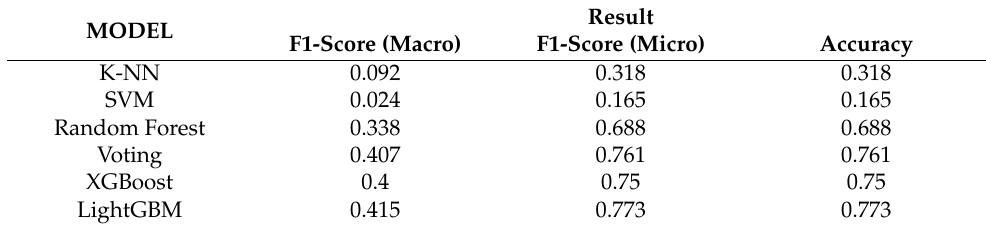
Table 4. R2Tour results for AI-based recommendation